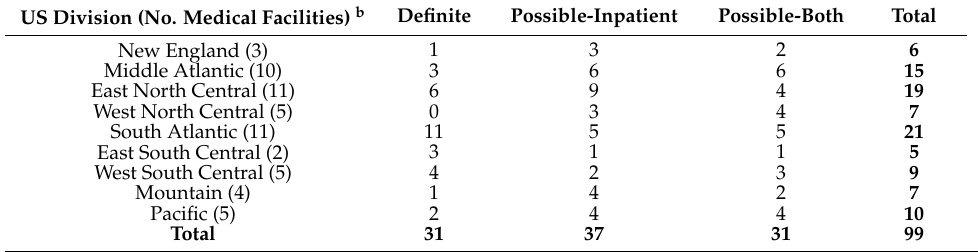
Table 4. VA LD cases, by case classifications and U.S. Census Division. a.